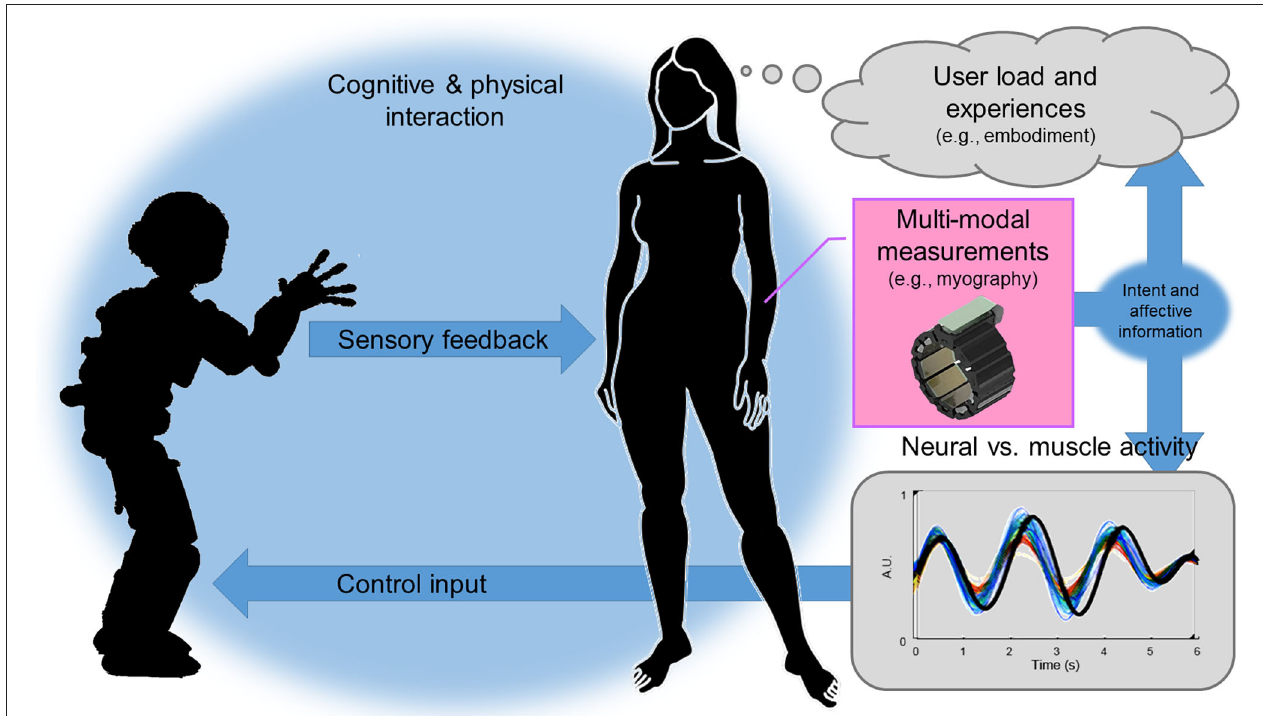
FIGURE 1 | Peripheral-Nervous-System–Machine Interfaces (PNS-MIs) in human-robot interaction: PNS data facilitates simultaneous intent recognition and online experience evaluation. This fosters novel sensorimotor interaction paradigms, sheds light on human behavior and reactions, and thereby opens up new directions for human-robot